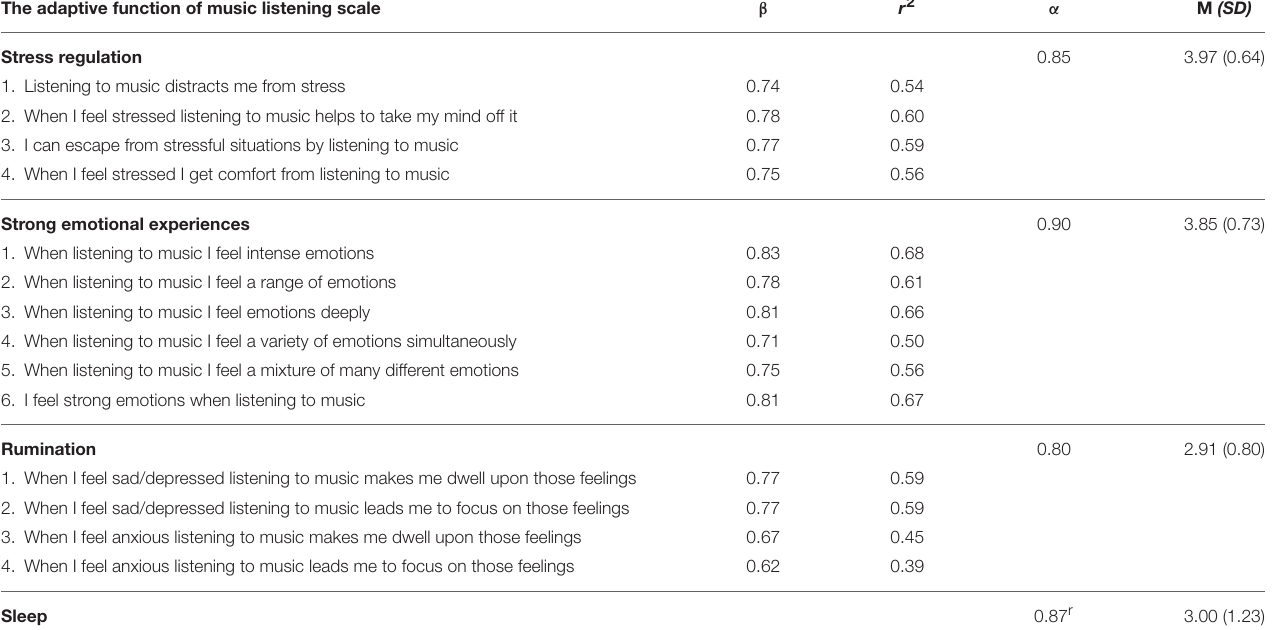
TABLE 4 | The adaptive functions of music listening scale, internal consistency and descriptive statistics of 11 subscales, and psychometric properties of 46 final scale items. The adaptive function of music listening